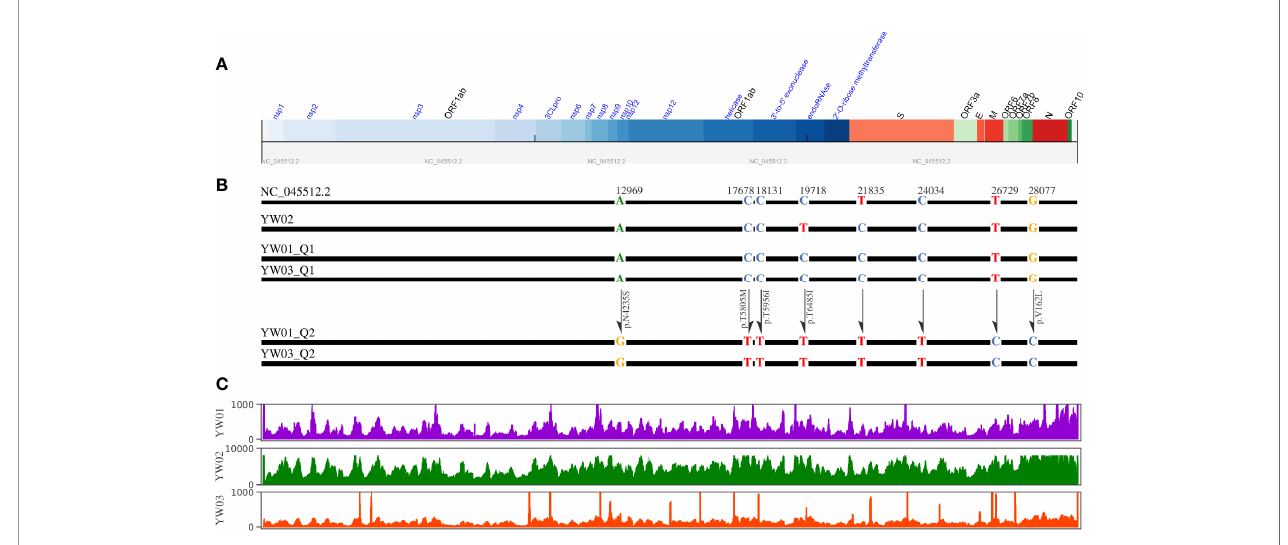
FIGURE 3 | Diagram of YW SARS-CoV-2 haplotypes. (A) Genome structure of SARS-CoV-2 reference strain (NC_045512.2); (B) Schematic diagram of YW haplotypes, where only the 8 speci fi c variants that detected in different haplotypes simultaneously are plotted; (C) Sequencing coverage of YW